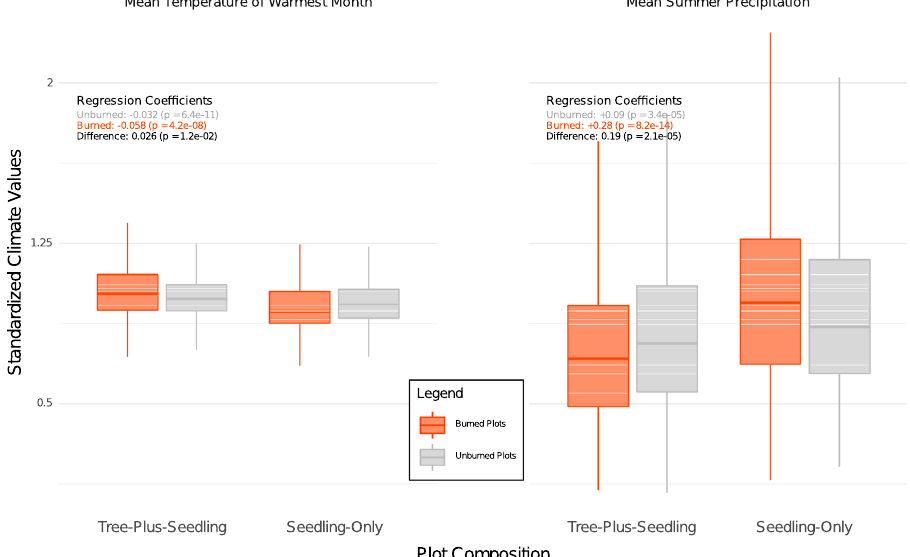
Fig. 4 The climatic components of SORD most impacted by wild fi re occurrence, separated by wild fi re history, and aggregated across species. The plot includes results for all species that share the direction of a statistically signi fi cant difference (two-sided t -test, p < 0.05) between seedling-only ( n = 1806) and tree-plus-seedling ( n = 5654) populations in unburned plots. The species included are: Chrysolepis chrysophylla , Pinus ponderosa , Pseudotsuga menziesii , Quercus chrysolepis , and Quercus kelloggii . Boxplots include the median line, a box denoting the interquartile range, and whiskers showing values ± 1.5x the interquartile range. This fi gure demonstrates that while these fi ve species show a trend in unburned seedling-only plots towards lower mean temperature of the warmest month and higher mean summer precipitation, the difference in burned plots is greater ( p < 0.01). Climate variables were standardized by dividing the values by their root-mean-squares. Multiple linear regression was used to quantify the difference in SORDs between burned and unburned samples. Supplementary Fig. 3 shows this analysis across the full suite of climate variables, including those where the difference between the SORDs of burned and unburned samples were not statistically signi fi cant. Source data are provided as a Source Data fi